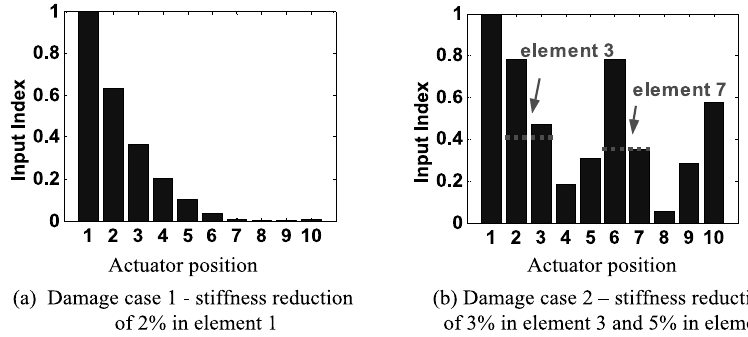
Fig. 4. Input index calculated using Eq. (14) for each of the actuator position.